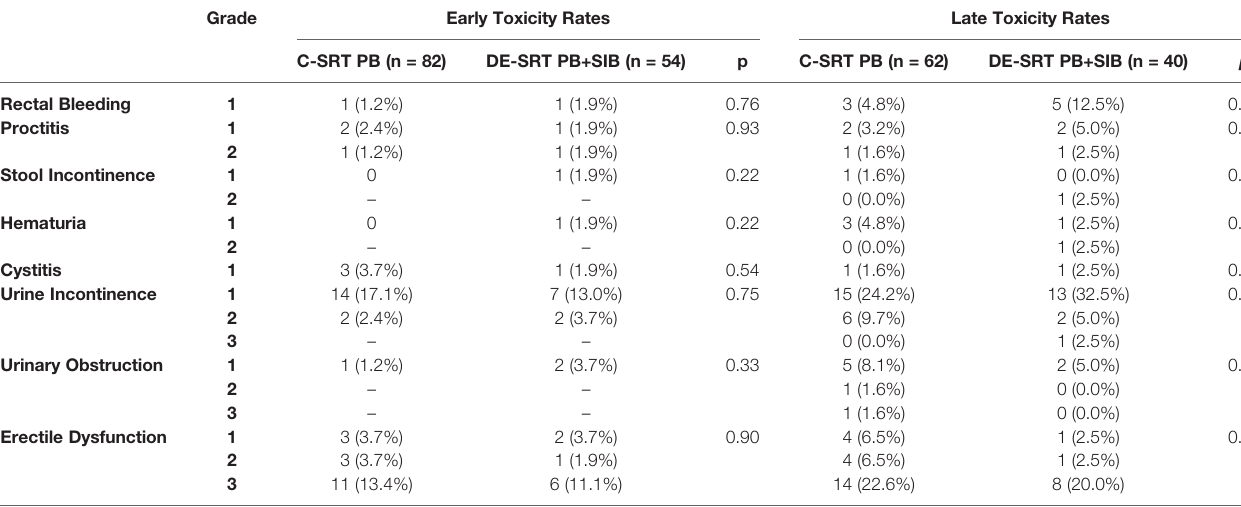
TABLE 5 | Comparison of newly diagnosed or worsened early and late toxicity rates of conventional salvage radiotherapy (C-SRT) to the prostate bed (PB) versus dose-escalated salvage radiotherapy (DE-SRT) to the PB and simultaneous-integrated boost (SIB) to a local recurrence.